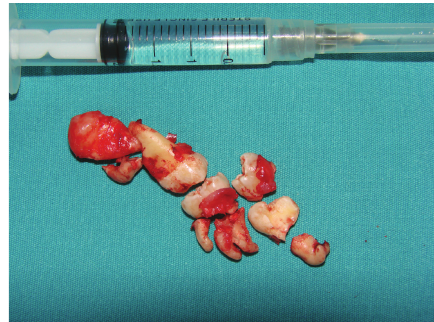
Figure 2: Split and removed impacted teeth.